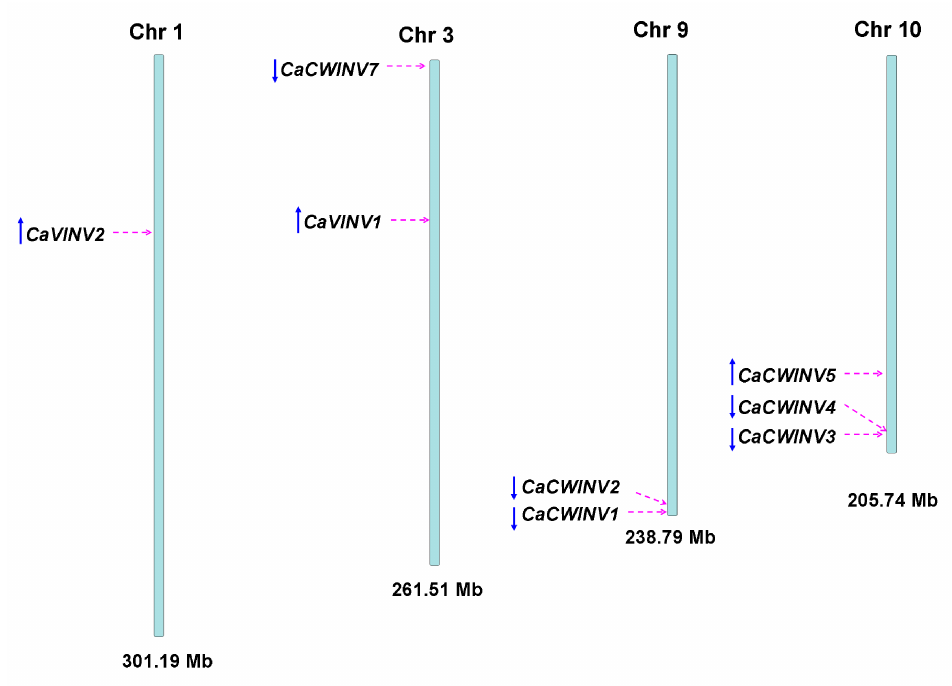
Figure 4. Chromosomal localization of CaAINV genes from pepper. The positions of the CaAINV genes are depicted by red arrows. The gene orientation is depicted by blue arrows.